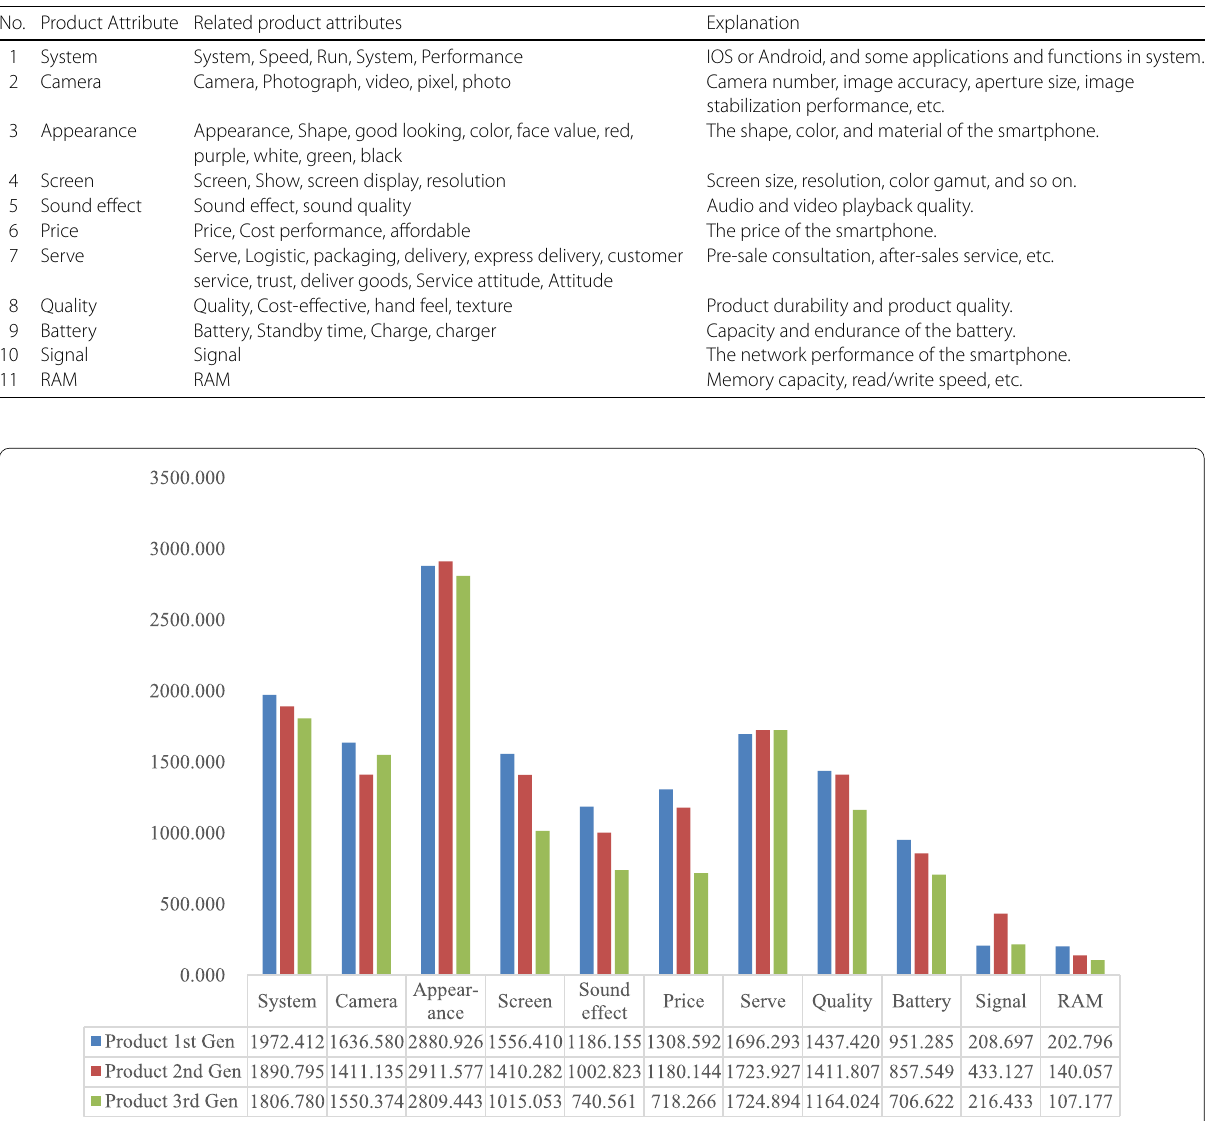
Figure 8 The sentiment scores for each product attribute of multi-generation